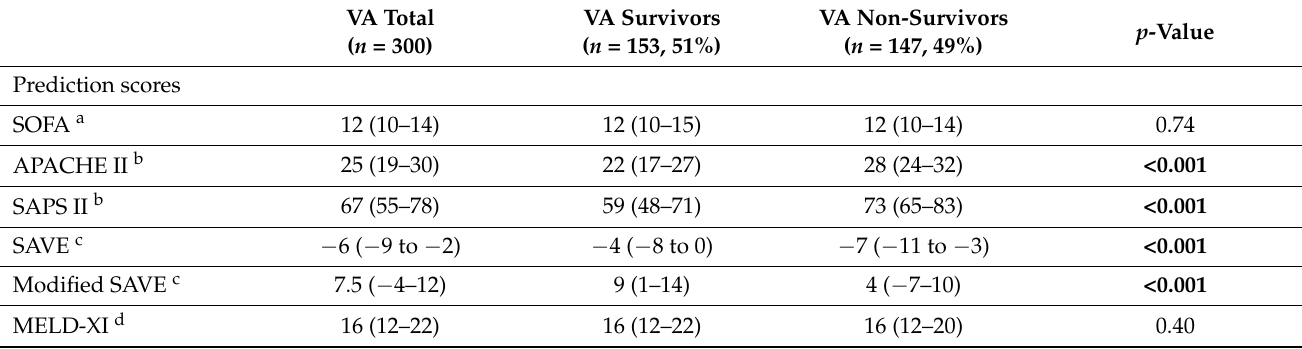
Table 2. Scoring results in patients on ECMO before implantation according to survival (veno-arterial ECMO